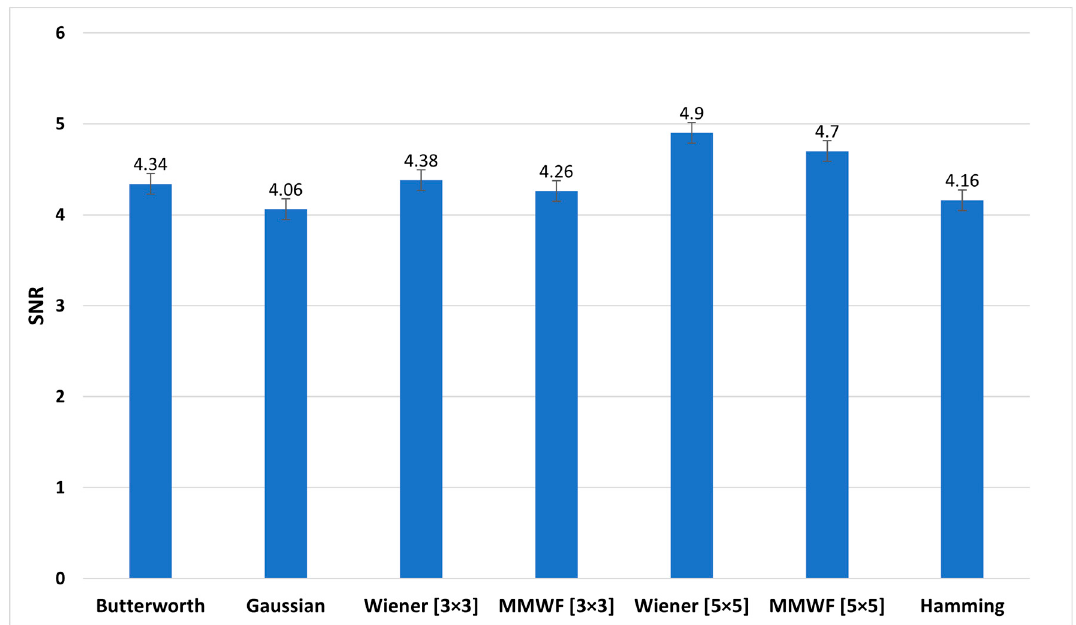
Figure 7. Images obtained by filtering the image of Figure 3 with Butterworth ( n = 5, fc= 0.3 Nq), Gaussian, Wiener (3 × 3), MMWF (3×3), Wiener (5×5), MMWF (5×5), and Hamming (fc= 0.3 Nq) filters (x × x represents the kernel size).